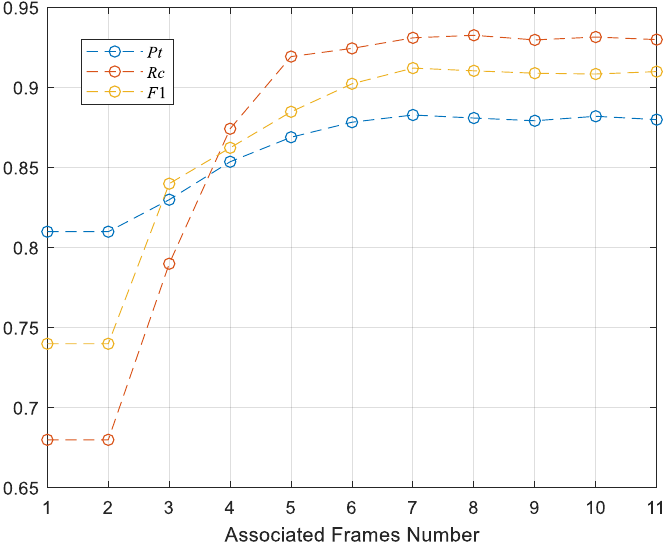
Figure 9. Performance comparison of different numbers of association frames and association discrimination results designed in this paper.